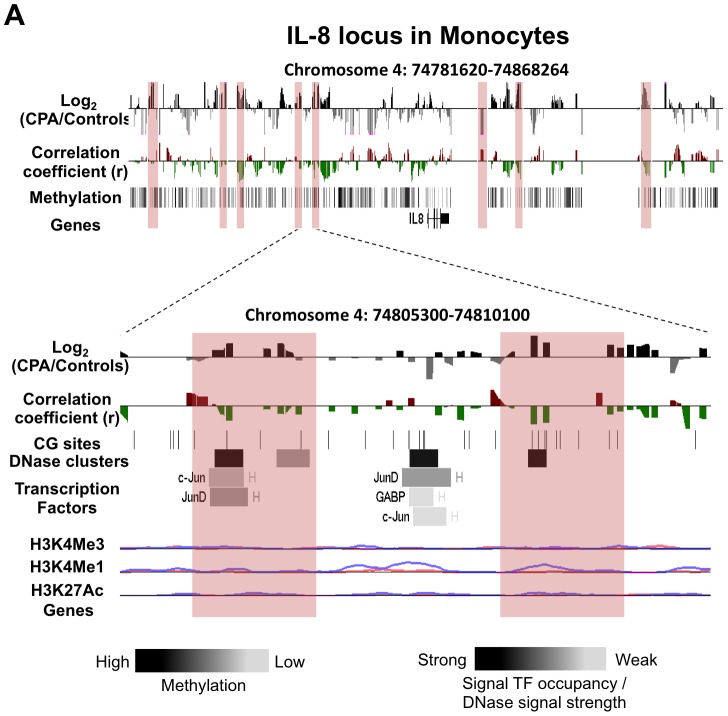
DNA methylation differences between CPA (n = 8) and control (n = 12) groups in pro-inflammatory chemokine IL-8 locus in monocytes.Expanded views from the UCSC genome browser of IL-8 (A) locus located on chromosomes 4 is depicted (top panel). In both panels, the first track shows the average MeDIP probe log2-fold differences (scale top panel: −0.4 to 0.4, botom panel: −1.0 to 1.0) between chronic physical aggressive (CPA) and control groups are shown for monocytes. In black are probes that are more methylated and in gray are those that are less methylated in the CPA group. Highlighted in red are regions significantly differentially methylated between the groups. The second track shows Pearson’s correlation coefficient (scale top panel: −0.4 to 0.4, botom panel: −0.5 to 0.5) calculated between MeDIP microarray probe intensities (DNA methylation levels) and the plasma IL-8 levels obtained from the same subject (n = 20). In red are probes whose methylation levels correlate positively with the cytokine levels in plasma and in green are those that correlated negatively. In the top panel, the last track shows the average methylation level for all the subjects in monocytes estimated from the microarray data. The bottom panel shows the closest region upstream of the TSS where the CPA group is found significantly less methylated than the control group in the IL-8 locus. In both regions, an overall negative correlation between methylation and cytokine level in plasma is observed but did not reach significance after correcting for multiple testing. The regulatory elements from ENCODE identified in these regions (see methods) are shown in the additional tracks. First, shown with black lines, is the location of individual CpG sites. Second, is the location of DNase hypersensitive clusters where black indicate strong signal and grey a weaker signal from ChIP-seq data in 24 cell lines. Third is the location of transcription factors (TF) identified from ChIP-seq data in 24 cell lines where black indicate a strong and grey weaker signal occupancy. The letter next to the TF boxes identified the cell line where it was found enriched (see Table S1 for the full legend). The last tracks, identified the level of enrichment of three histone marks determined from ChIP-seq assay, histone 3 lysine 4 tri- and mono-methylation as well as histone 3 lysine 27 acetylation in two cell lines, GM12878 (pink) and K562 [106].